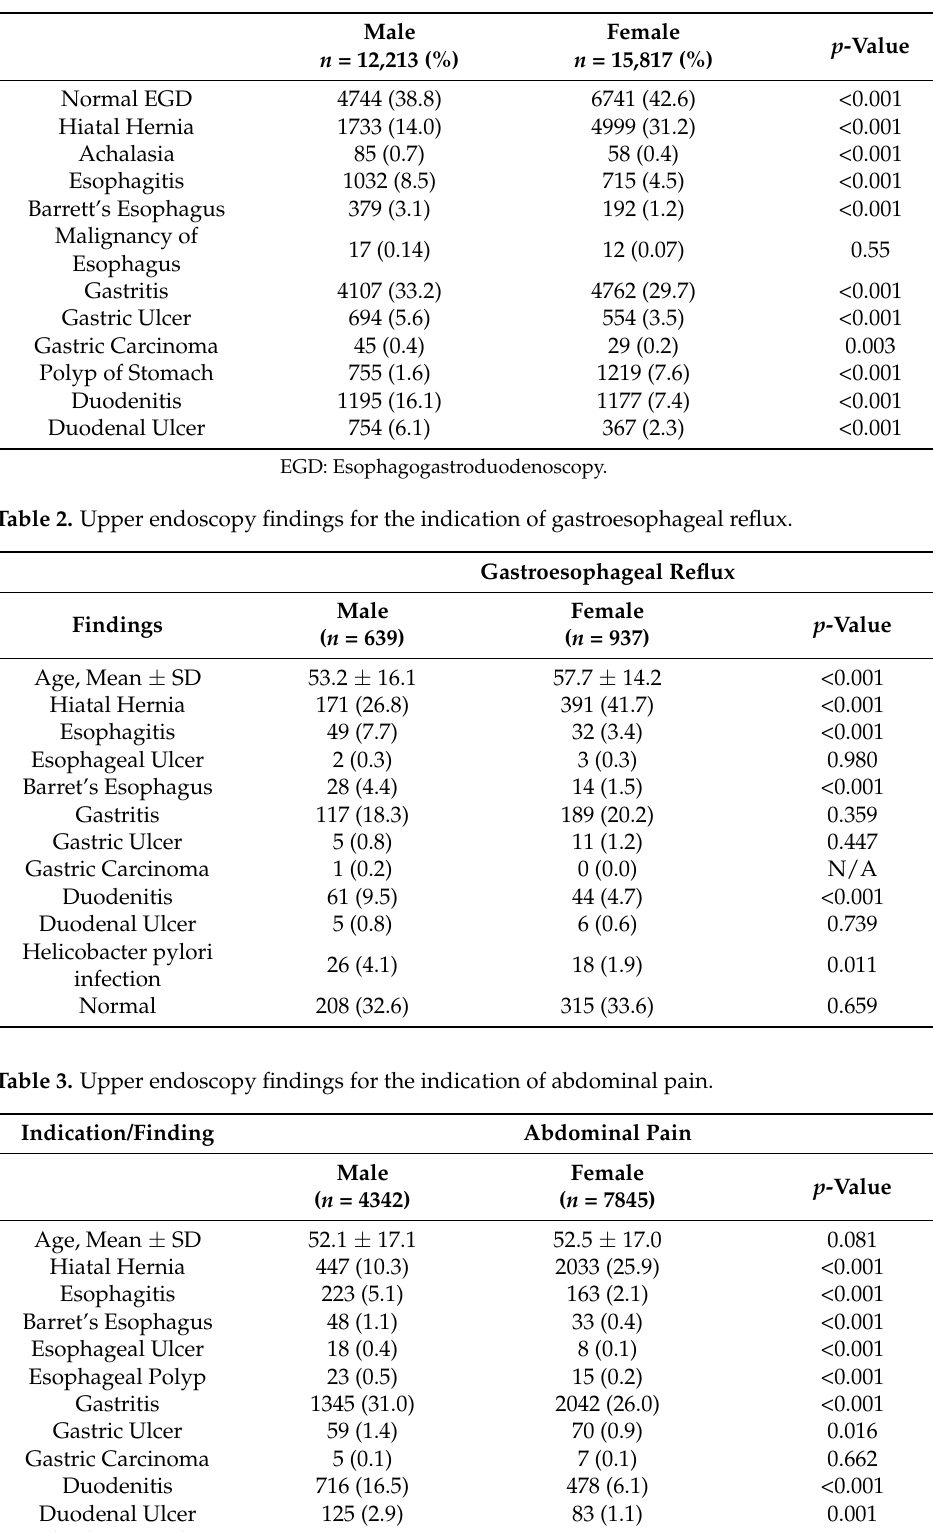
Table 1. Upper endoscopy findings among all included cohorts.